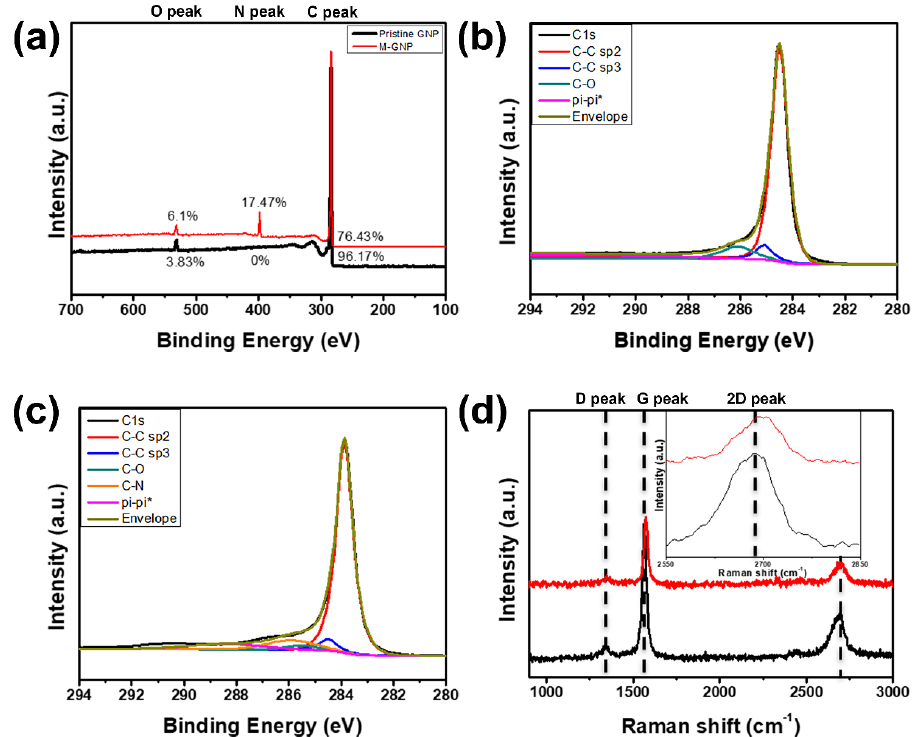
Figure 1. X-ray Photoelectron Spectroscopy (XPS) of GNP and M-GNP. ( a ) Survey and ( b ) high resolution C1s peak regions of GNP and ( c ) M-GNP. ( d ) The Raman spectroscopy of GNP and